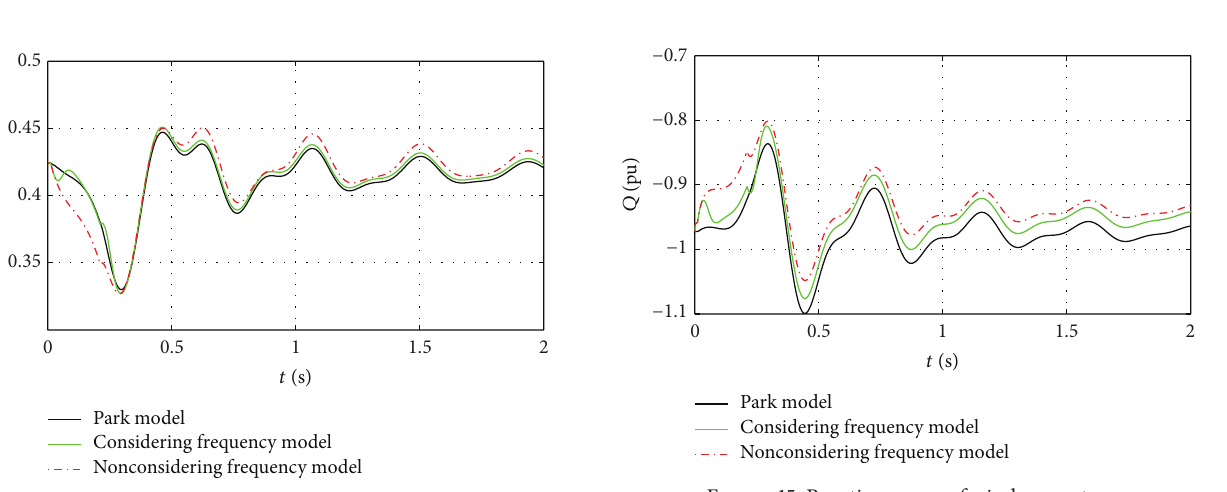
Figure 13: Reactive power of induction motor.